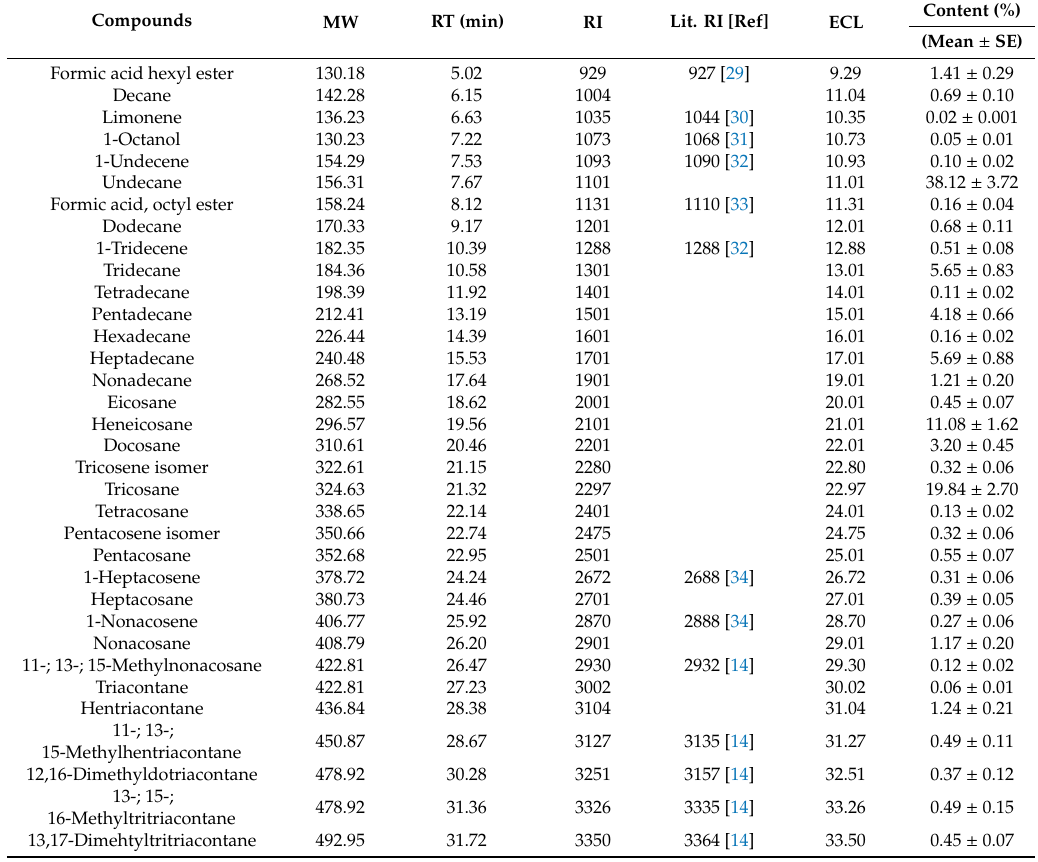
Table 1. Cuticular compounds (CCs) isolated from workers of Oecophylla smaragdina . Compounds Formic acid hexyl